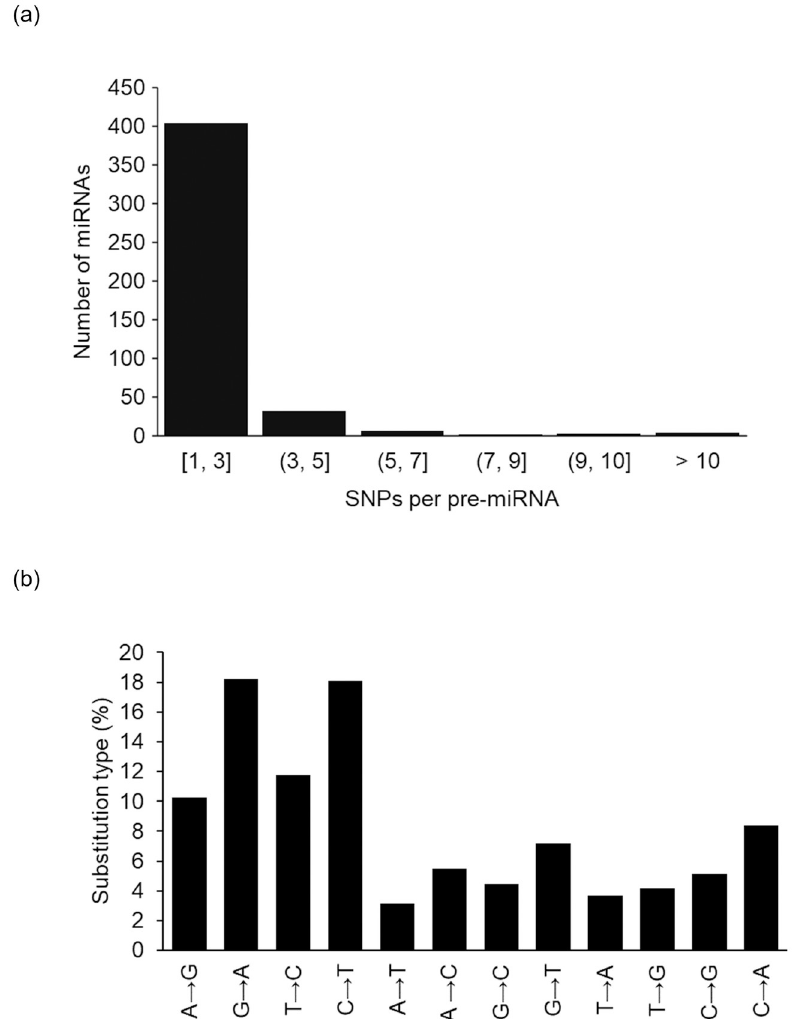
Fig 1. Frequency distributions of SNPs per miRNA primary sequences (a) and nucleotide substitution type (b) in primary sequences. Arrows indicate the direction of change, based on the reference genome.